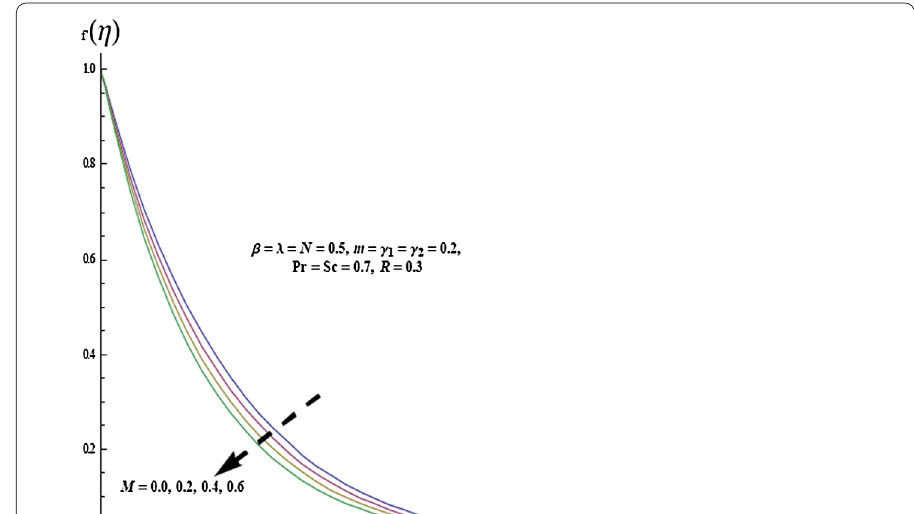
The impacts of Hartman number M , Hall parameter m , mixed convection parameter λ and concentration buoyancy parameter N on the transverse velocity profile h ( η ) are de- picted in Figures -. Figure  shows that the transverse velocity h ( η ) increases with an increase in Hartman number M . It is also noticed that the momentum boundary layer thickness reduces for larger M . The effect of Hall parameter m on the transverse veloc- ity h ( η ) is displayed in Figure . As Hall parameter m increases, the transverse velocity h ( η ) decreases and the associated boundary layer thickness increases. The effect of mixed convection parameter λ on the transverse velocity profile h ( η ) is analyzed in Figure